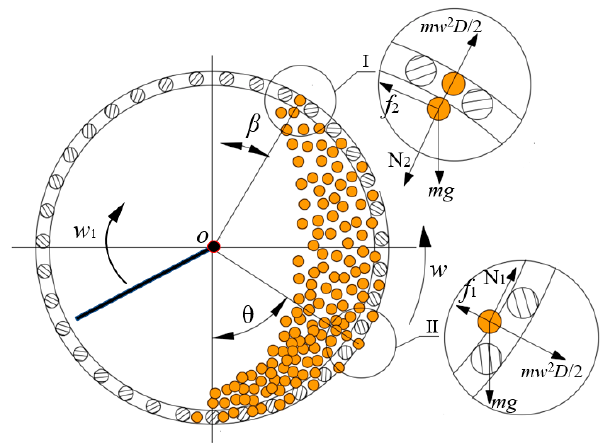
Figure 7. Stress analysis of BSF sand at the critical location. Note: m denotes the BSF sand mass, g; w is the angular velocity of cylinder sieve, rad · s − 1 ; I and II represent the low and high points, respectively; w 1 represents the angular velocity of the spike teeth, rad · s − 1 ; β is the angle between the lines connecting the BSF sand at the highest point and the circle center and the vertical center line in a force balance state, rad; θ expresses the angle between the lines connecting the BSF sand passing through the sieve holes and the circle center with the vertical center line, θ (cid:15) ( α , π − β ), rad; D is the internal diameter of the cylinder sieve, m; f 2 is the friction at the highest point, N; N 2 is the supporting force at the highest point, N; f 3 is the friction when the rapeseed passes through the sieve holes, N; and N 3 is the supporting force when the rapeseed passes through the sieve holes,